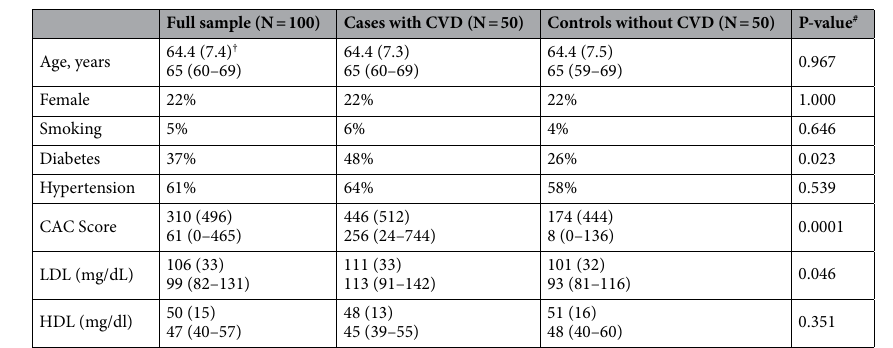
Table 1. Sample characteristics of the MASALA case–control sample, 2010–2018 * . *Match factors: Age and Sex. † First row is mean and standard deviation. Second row is median and range (25 th -75 th percentile). # Wilcoxon Rank Sum or Chi-square test.